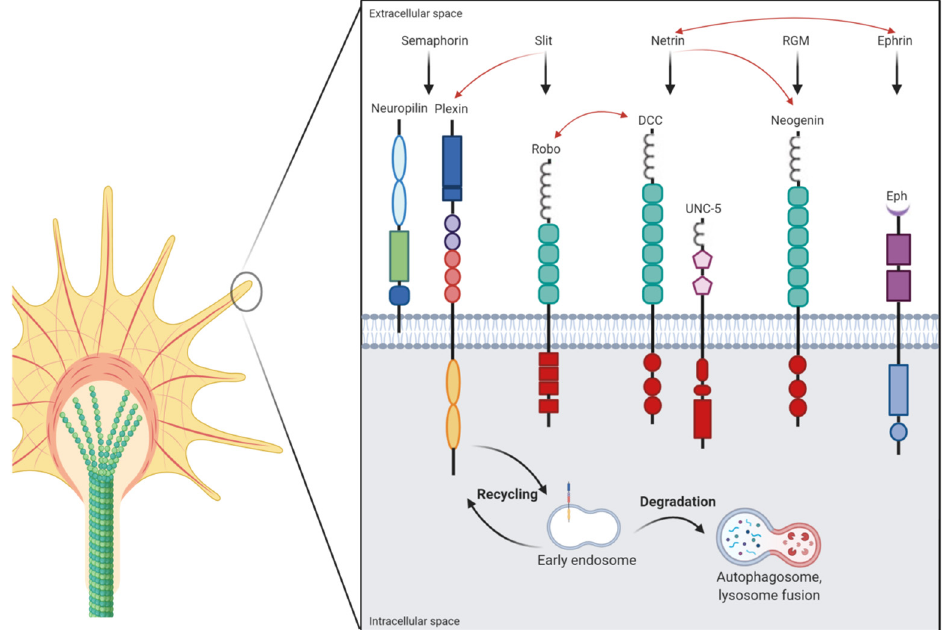
Figure 1. Axon guidance cues and endo-lysosomal pathway in the axonal growth cone. A schematic picture depicts the modular structure of major axonal guidance cue-related receptors and their respective ligands. Classical interactions are represented by black arrows, while red arrows indicate crosstalk between different axon guidance families. In the bottom part of the figure, the endosomal– lysosomal compartment is shown to mediate both receptor recycling and degradation. (created with